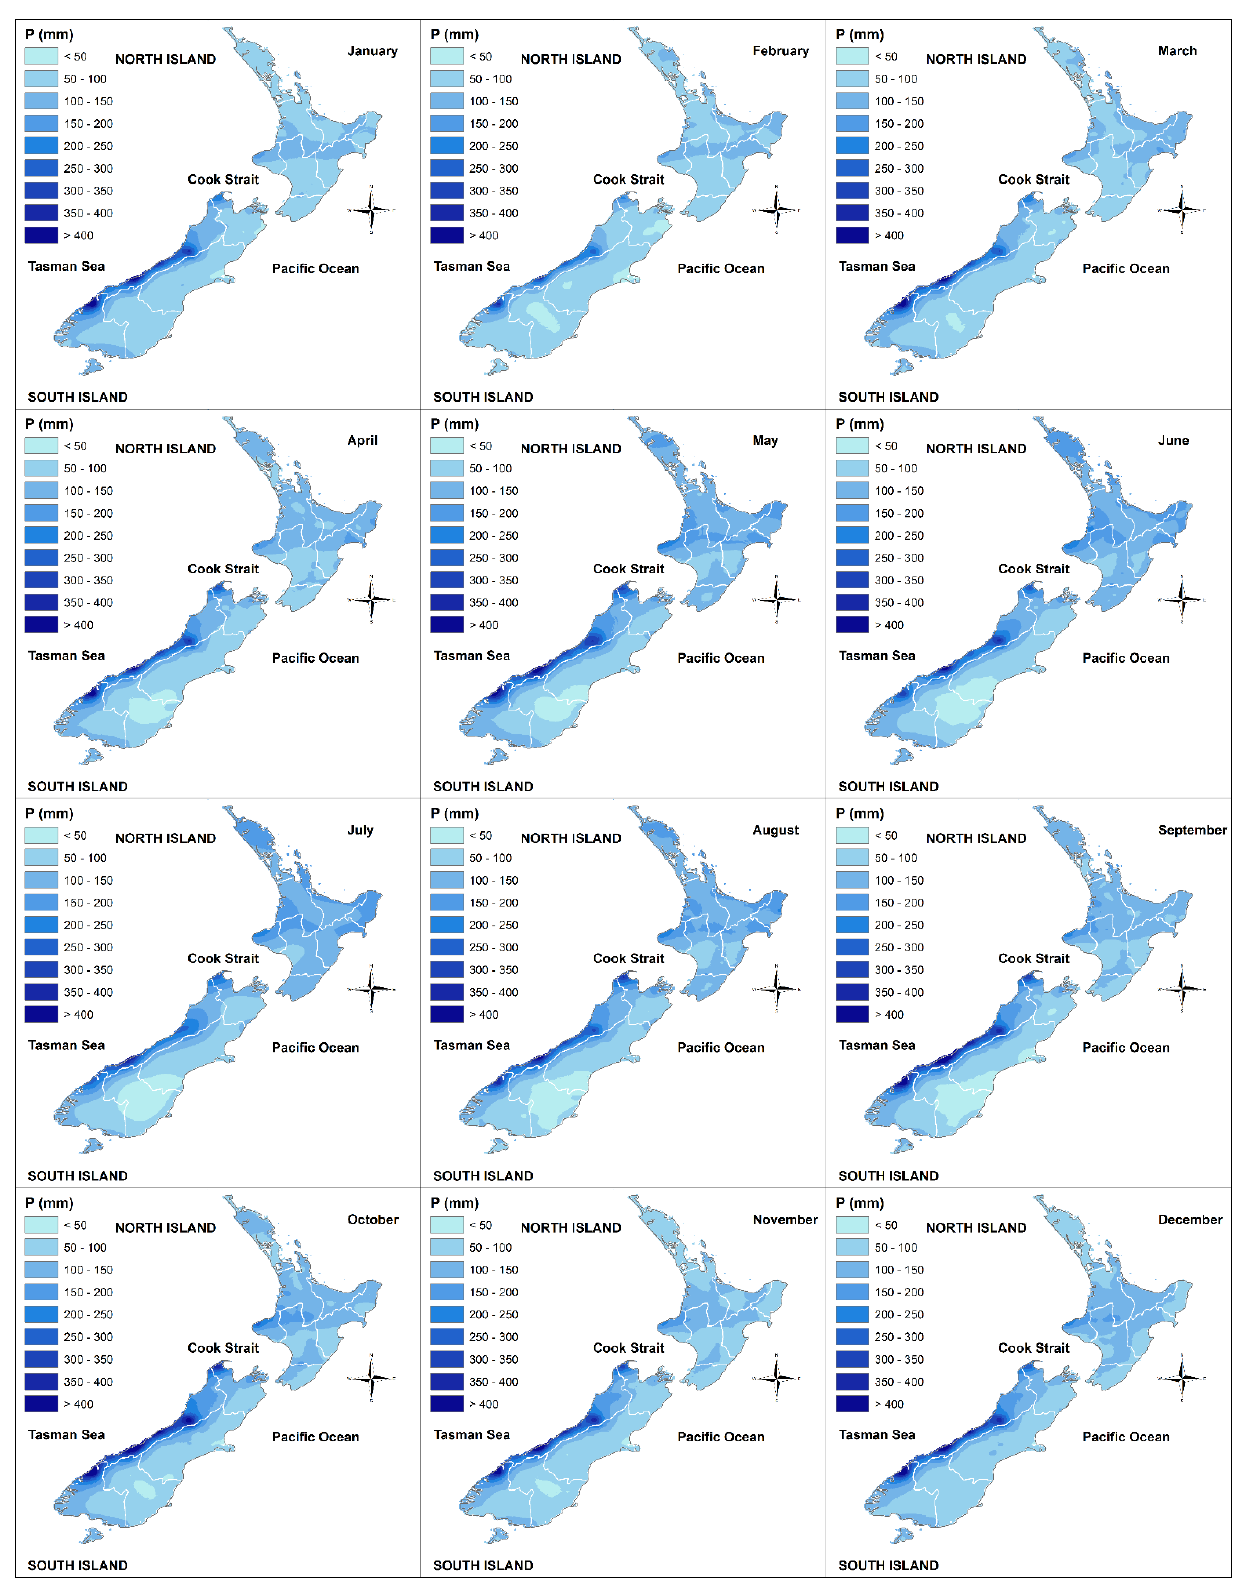
Figure 6. Mean monthly precipitation interpolated using ordinary cokriging (COK) method.